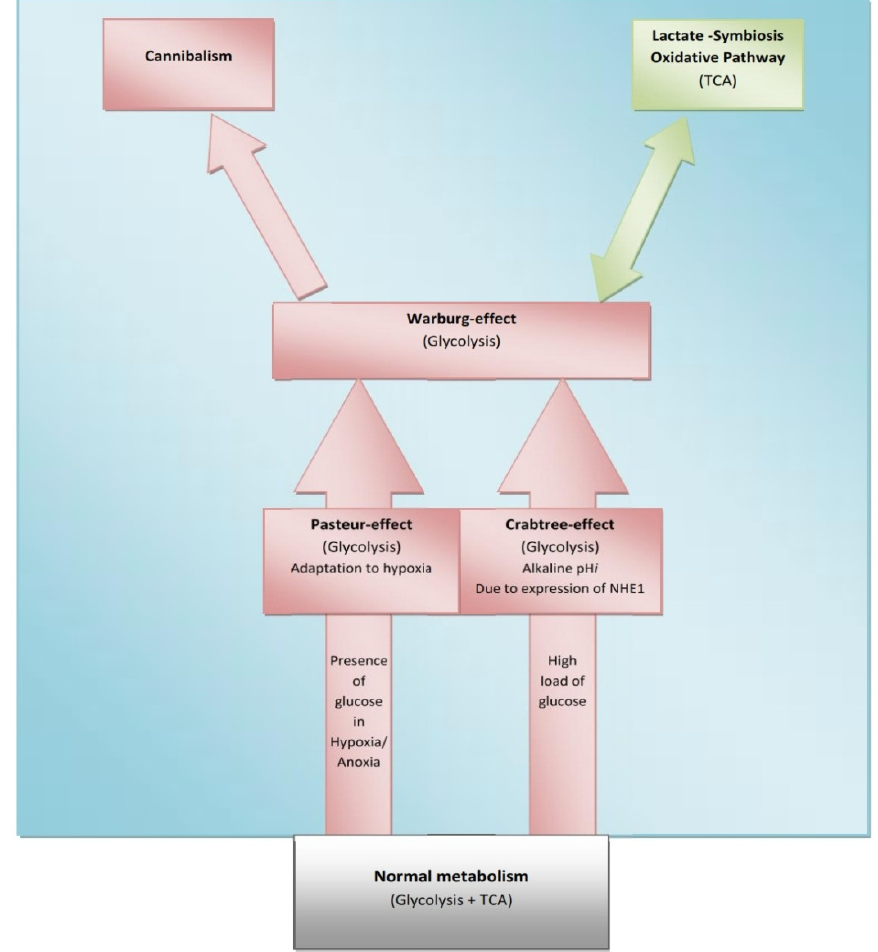
Figure 2. Cancer as integrated metabolic ecosystem, This model describes the possible pathways of carcinogenesis associated with metabolic phases of transformation. The green background reflects the tumor microenvironment which represents the medium on which carcinogenesis steps have occurred. Normal metabolism occurs does not create the tumor microenvironment which is why it is presented outside of the green